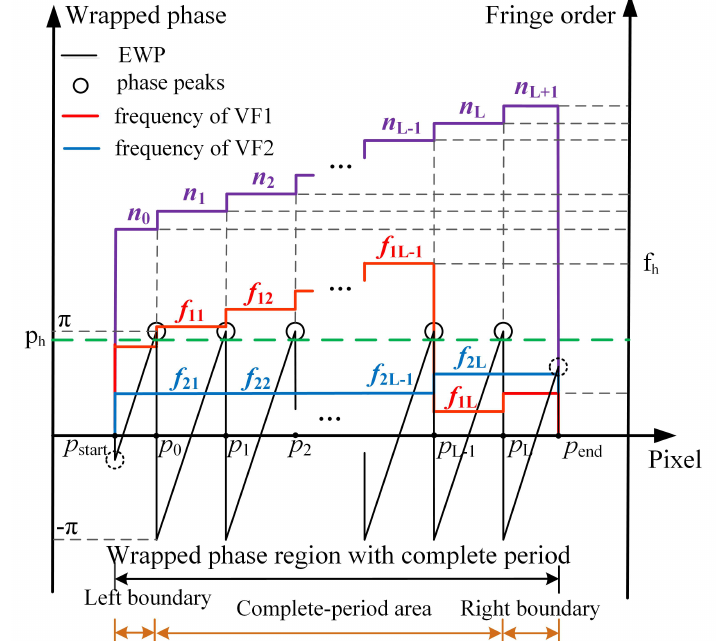
Figure 4. Orders decoding of wrapped phase with complete period.